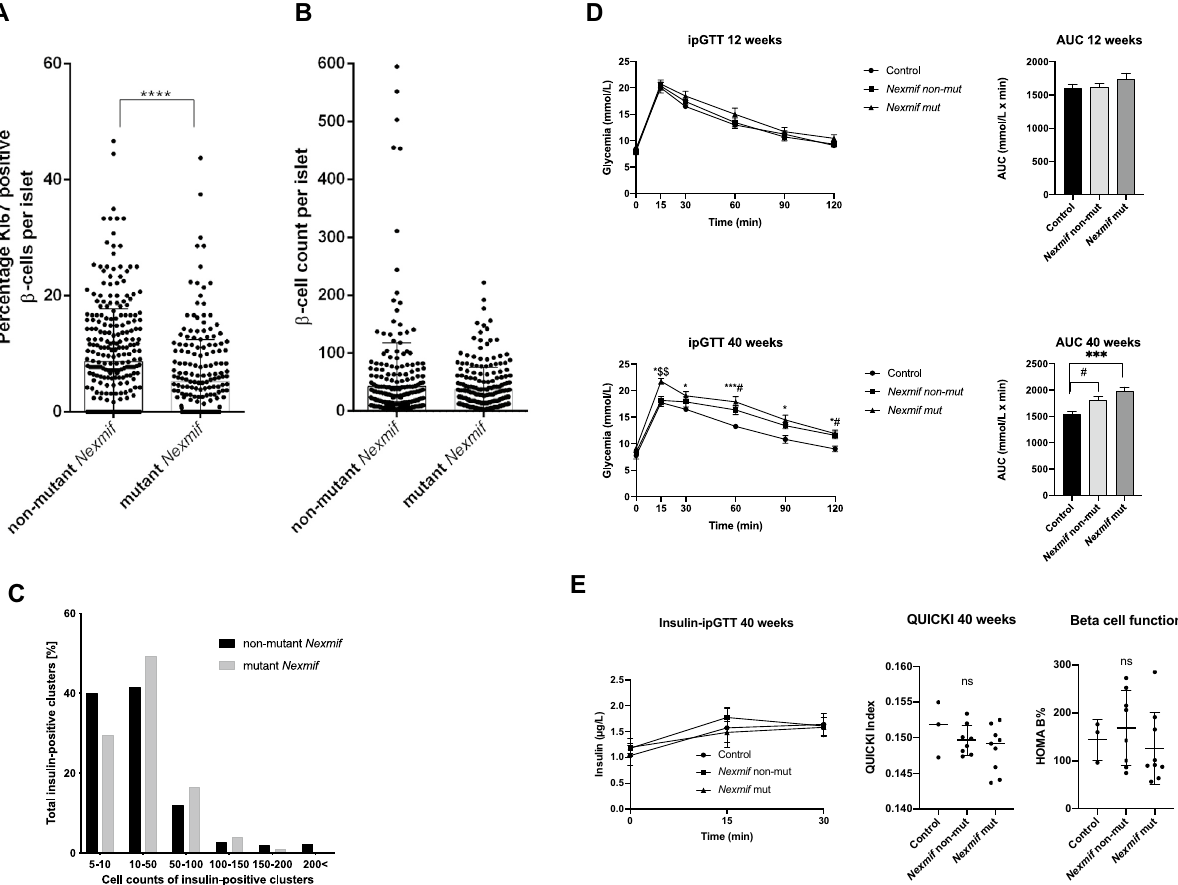
Figure 2. Pancreatic islet proliferation and function in Nexmif mutant mice. ( A ) Percentage of proliferating beta cells marked by Ki67 in the pancreatic islets of Nexmif non-mutant (n = 3) and mutant mice (n = 3) at postnatal day 21. Error bars indicate the standard deviation. The box plots are presented as median with 25th percentiles (boxes). Two-tailed unpaired Student t-test. ****P ≤ 0.0001. ( B ) Beta-cell counts in pancreatic islets of Nexmif non-mutant (n = 3) and mutant mice (n = 3) at postnatal day 21. ( C ) Islet size distribution in Nexmif non-mutant (n = 3) versus mutant mice (n = 3) at postnatal day 21. ( D , E ) Area under the curve for glucose levels and determination of insulin levels after intra-peritoneal glucose tolerance tests in control C57BL6 mice outside the colony at 12 weeks (n = 3) and 40 weeks (n = 3), Nexmif non-mutant mice at 12 weeks (n = 8) and 40 weeks (n = 13), and Nexmif mutant mice at 12 weeks (n = 12) and 40 weeks (n = 18). Only male mice were used. Error bars indicate the standard deviation and “n” is the sample size. Significance was determined using 2-way ANOVA for repeated measurements followed by a multiple comparisons post hoc test. * Control vs. Nexmif mutant, P ≤ 0.05; *** Control vs. Nexmif mutant, P ≤ 0.001; $$ Nexmif non-mutant vs. Nexmif mutant, P ≤ 0.01; # Control vs. Nexmif non-mutant, P ≤ 0.05. Ns: non-significant. The quantitative insulin sensitivity check index (QUICKI) was calculated with the following formula: 1/(log(fasting insulin μU/mL) + log(fasting glucose mg/ dL)) 17 , the HOMA B% with (20 × Insulin μU/mL)/(glucose (mmol/l) – 3.5) 16,66 . Significance was determined using one-way ANOVA analysis. Error bars indicate the standard